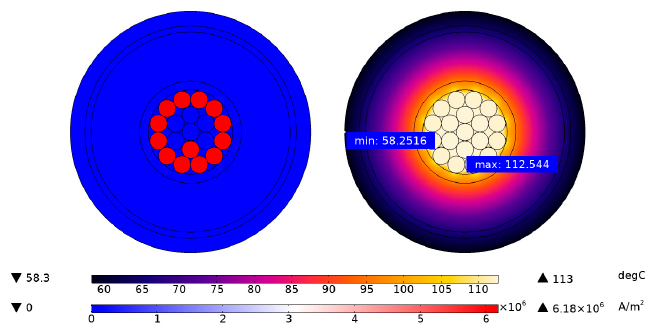
Figure 12. Distribution of the temperature field in °C ( right ) and current density in A/m² ( left ) when the conductor is mechanically damaged (six-wire failure).